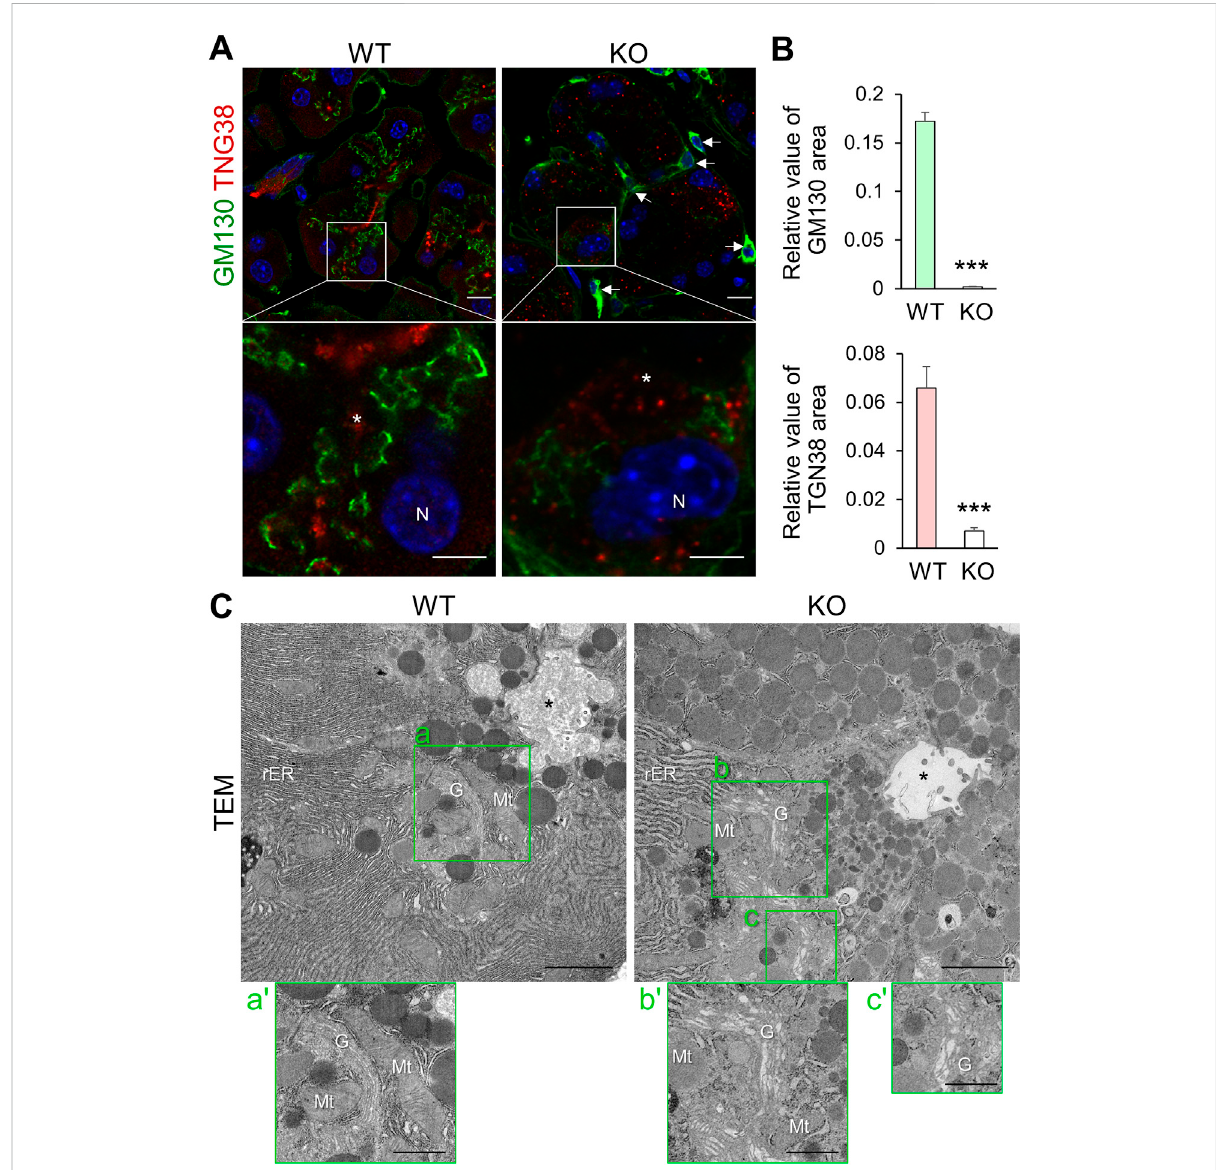
FIGURE 2 Cadps2- KOmiceexhibitimpairedorganelle structureinthecytoplasm ofpancreaticacinar cells. (A) ,Immunostainingofpancreaticacinarcells of WT and KO mice. Acinar cells were double-stained with the cis -Golgi network maker GM130 ( green ) and the trans -Golgi network marker TGN38 ( red ). KO sections are typical acinar cells that still retained weak signals for TGN38 and GM130. DAPI-positive nuclei ( blue ). Asterisks indicate acinar lumen. Arrows indicateinterstitialcellspositiveforGM130.N,nucleus.Scalebars:10 μ mintoppanelsand5 μ minbottommagni fi edpanels. (B) , Comparison of GM130-and TGN38-positive areas in pancreatic acinar cells between WT ( n = 3) and KO ( n = 4) mice at 6 – 9 months of age. In GM130 immunostaining, a total of 29 and 43 cells were analyzed for WT and KO, respectively. In TGN38-immunostaining, a total of 29 and 30 cells were analyzed for WT and KO, respectively. Relative values of immunopositive area/cell area (mean ± SEM, p -value determined using Student ’ s t- test): forGM130, WT =0.1720 ± 0.0094, KO =0.0012 ± 0.0004, p = 2.68E-33; for TGN38, WT = 0.0659 ±0.0089, KO= 0.0071± 0.0013, p =1.12E- 08. *** p < 0.001. (C) , Electron microscopy of the fi ne architectures of the intracellular organelles in pancreatic acinar cells of WT and KO mice at 6 months of age. Images a ’– c ’ on the bottom of each panel are magni fi ed views of the Golgi complex surrounded by green square areas a ’– c ’ , respectively. Asterisks indicateacinarlumen.G,Golgi;Mt,mitochondria;N,nucleus;rER,roughER.Scalebars:1 μ mforleftparentalimagesand2 μ m for right magni fi ed